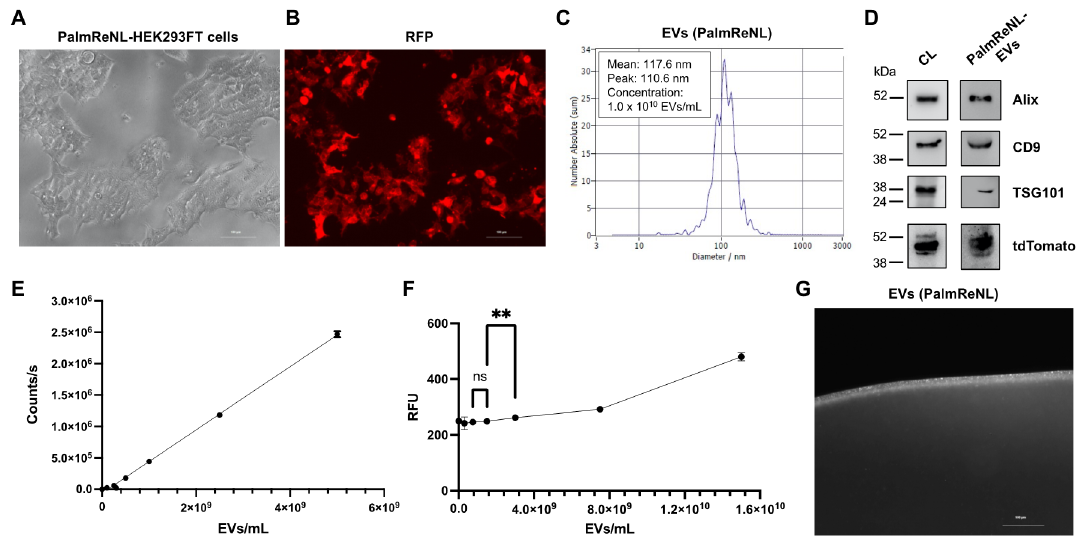
Figure 1. Characterization of dual-reporter PalmReNL-EVs. ( A ) An image of phase contrast in HEK293FT cells stably expressing PalmReNL. ( B ) A fluorescence image of PalmReNL-HEK293FT cells. Scale bar = 100 µm. ( C ) PalmReNL-EVs were analyzed by nanoparticle tracking analysis (NTA). ( D ) Western blot analysis of exosome marker proteins in PalmReNL-HEK293FT cells and -EVs. ( E ) Bioluminescence analysis of PalmReNL-EVs using furimazine. ( F ) Fluorescence signals in PalmReNL-EVs measured by using a plate reader; ns: not significant; **, p < 0.01. ( G ) A droplet of buffer containing isolated PalmReNL-EVs visualized by fluorescence microscopy. Scale bar = 10 µm.